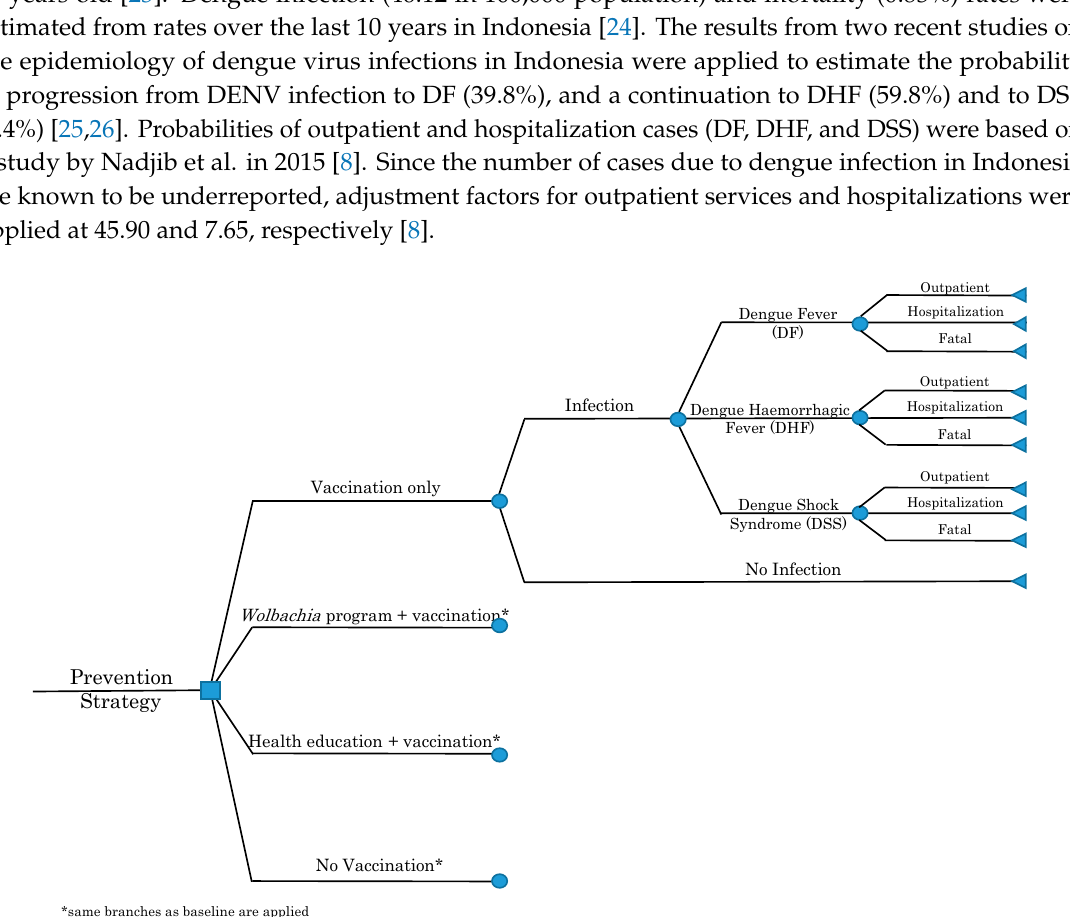
Figure 1. Decision tree model.